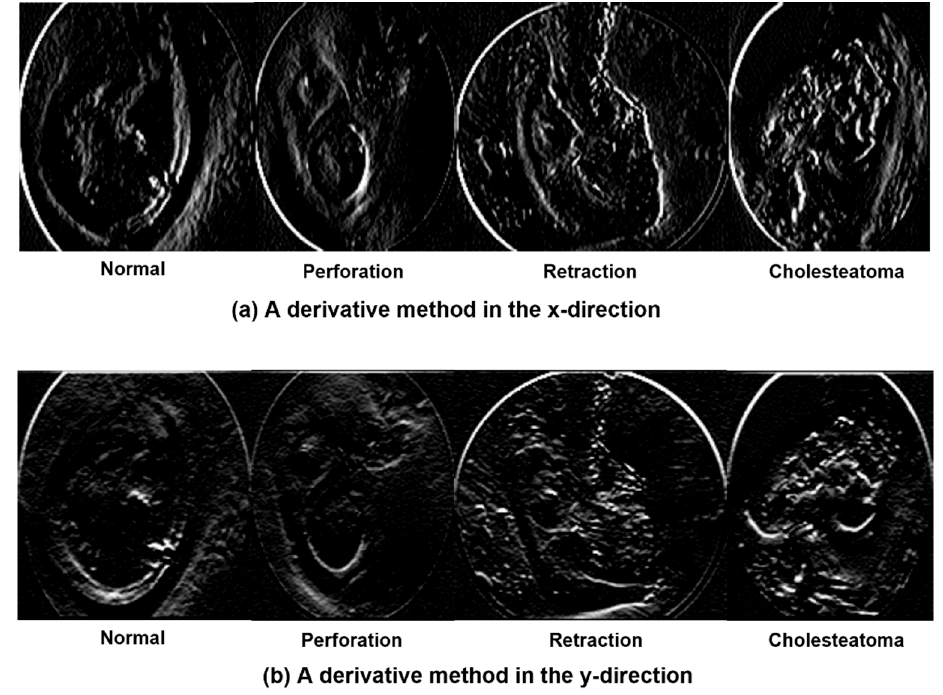
Figure 7. Images according to the derivative direction of Sobel edge detection.